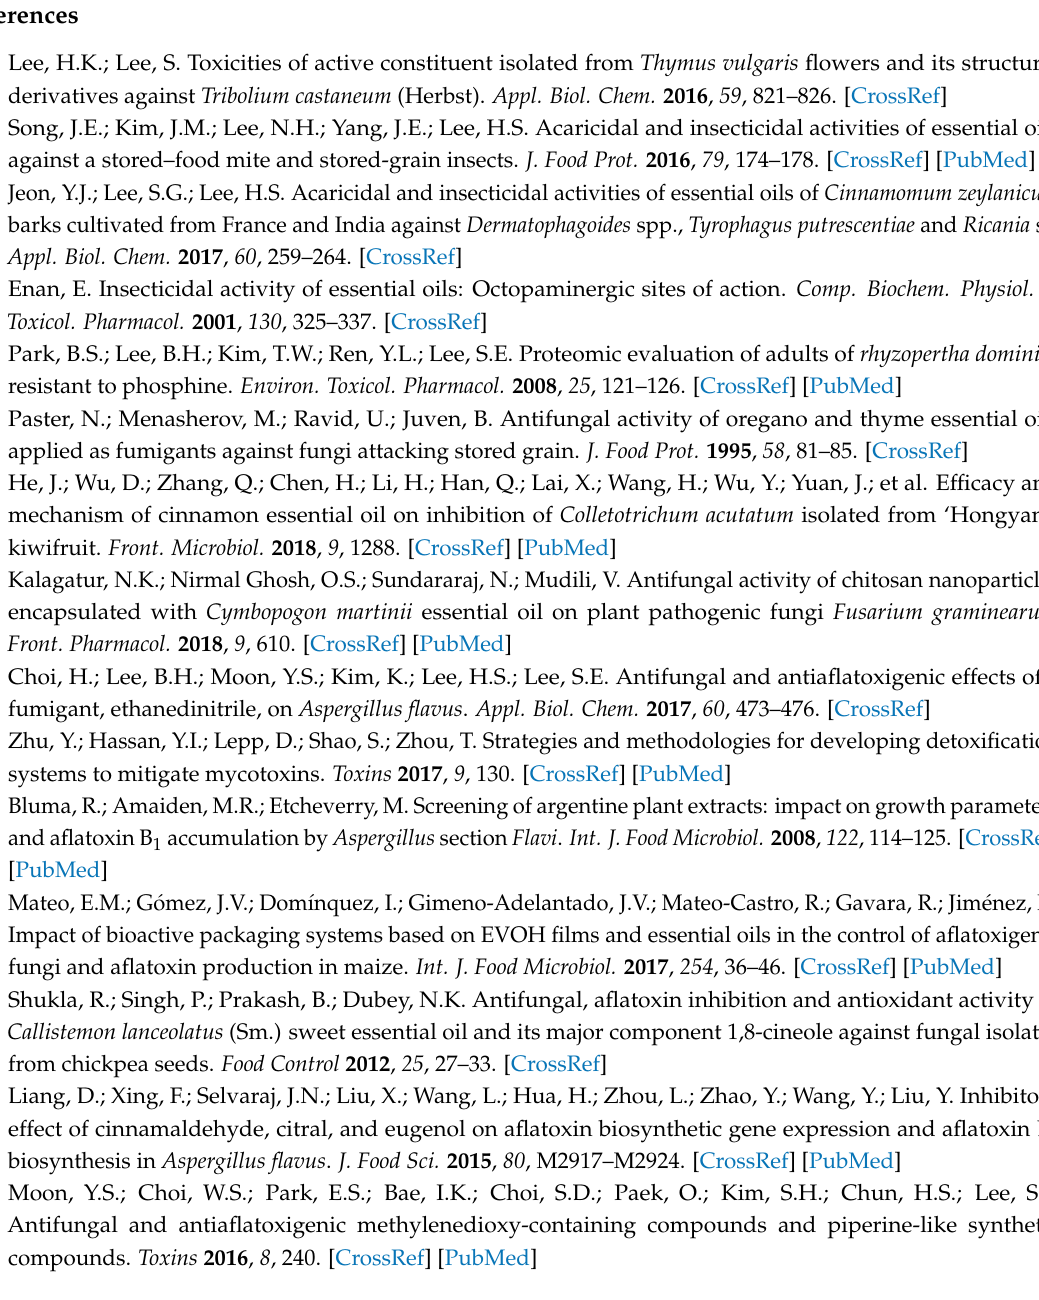
Table S1: Primers used in this study for RT-qPCR. They are related to the genes involved in aflatoxin and ergosterol production in Aspergillus flavus